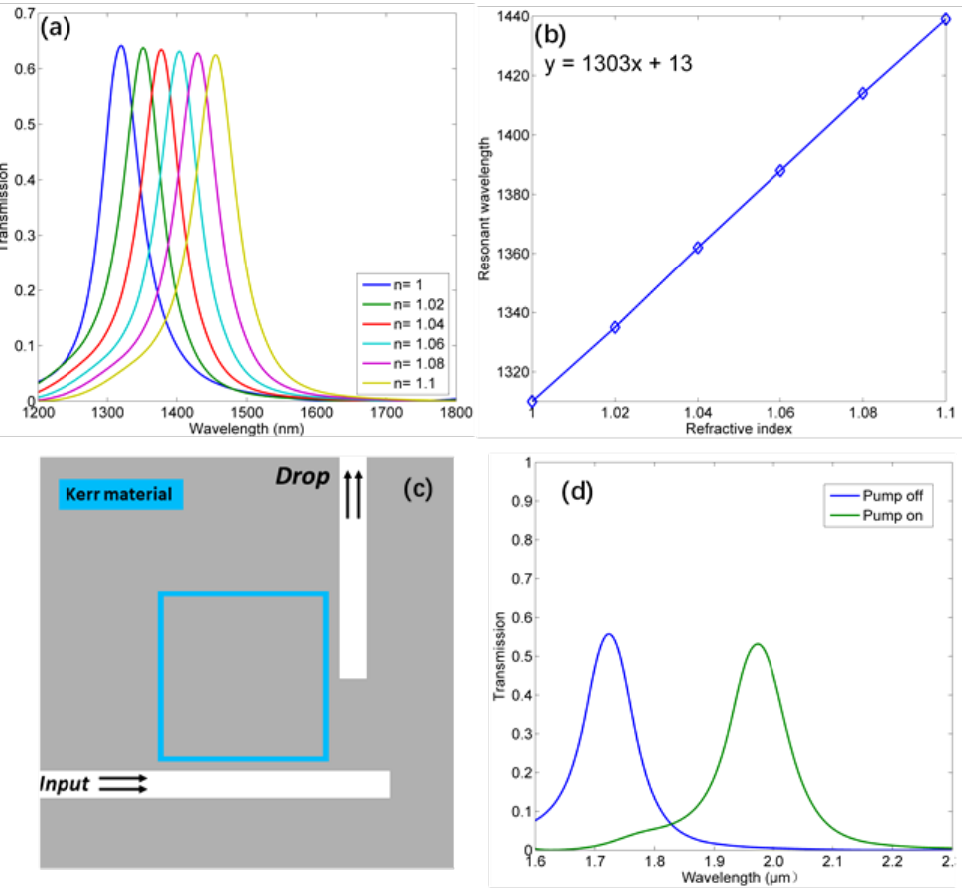
Figure 4. ( a ) The drop spectrum corresponding to different environmental refractive index (RI) values. ( b ) The inset is the linear relationship between the drop wavelength and environmental RI. ( c ) The schematic diagram of the optical switching device. ( d ) The drop spectrum for optical switching with or without the pump light.